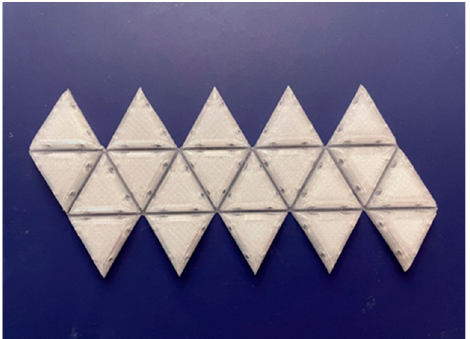
Figure 14. A 3D printed Dürer net of an icosahedron (laid out in a configuration like the origami model of a Satellite Tobacco Necrosis Virus in Figure 1) where the hinges are thinner and are printed in a flat lower layer before the convex domes on each triangular subunit are printed in subsequent layers.